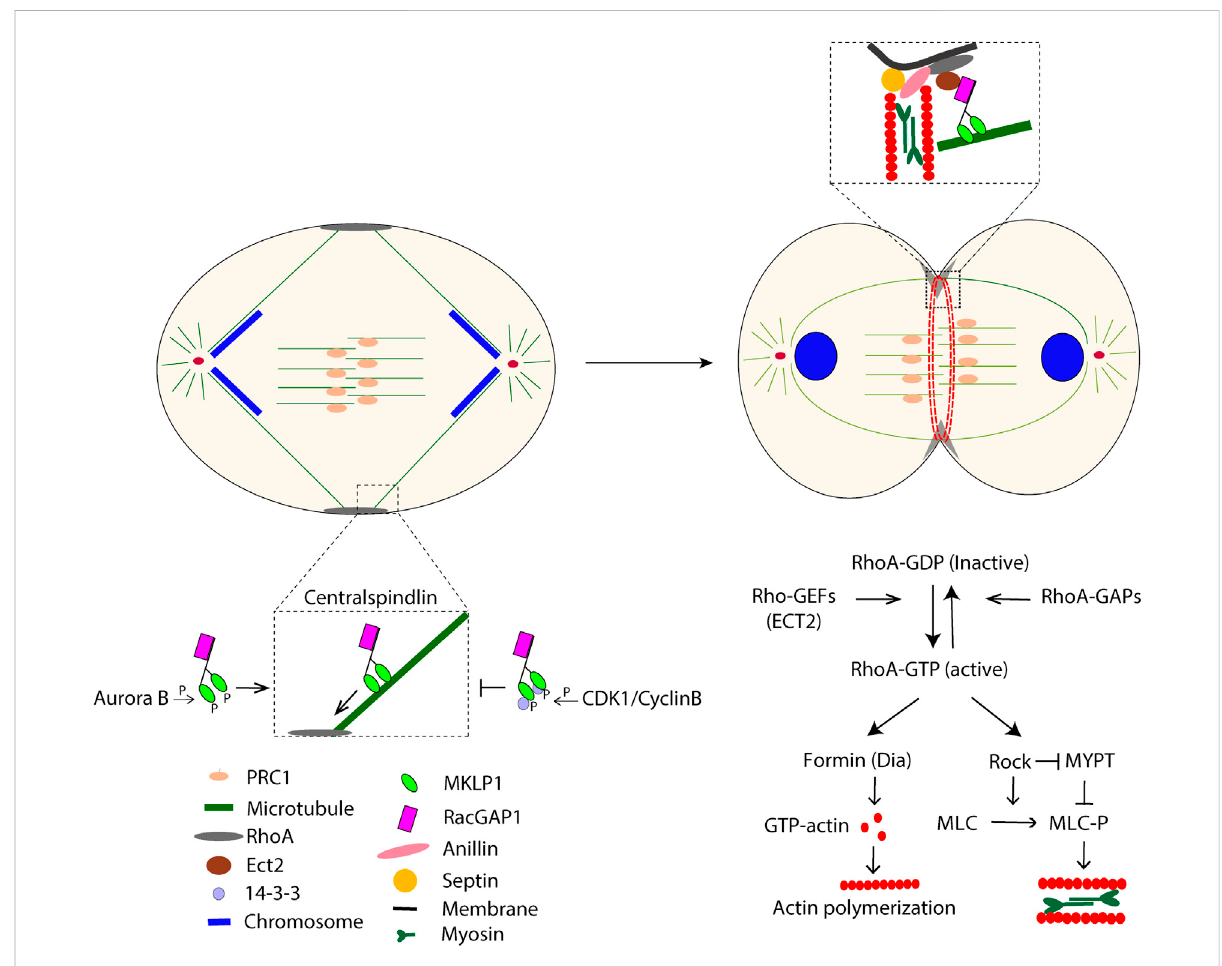
FIGURE 1 The schematic picture illustrates some major events during cytokinesis that start at